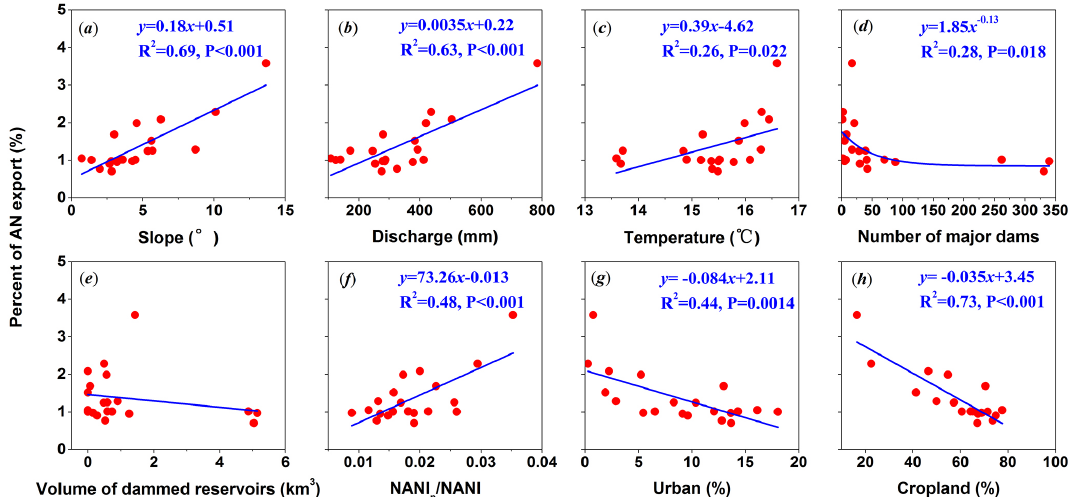
Figure 5. Regressions between AN export as a percent of NANI (%) and individual independent variables across the subbasins of the HRB ( n =